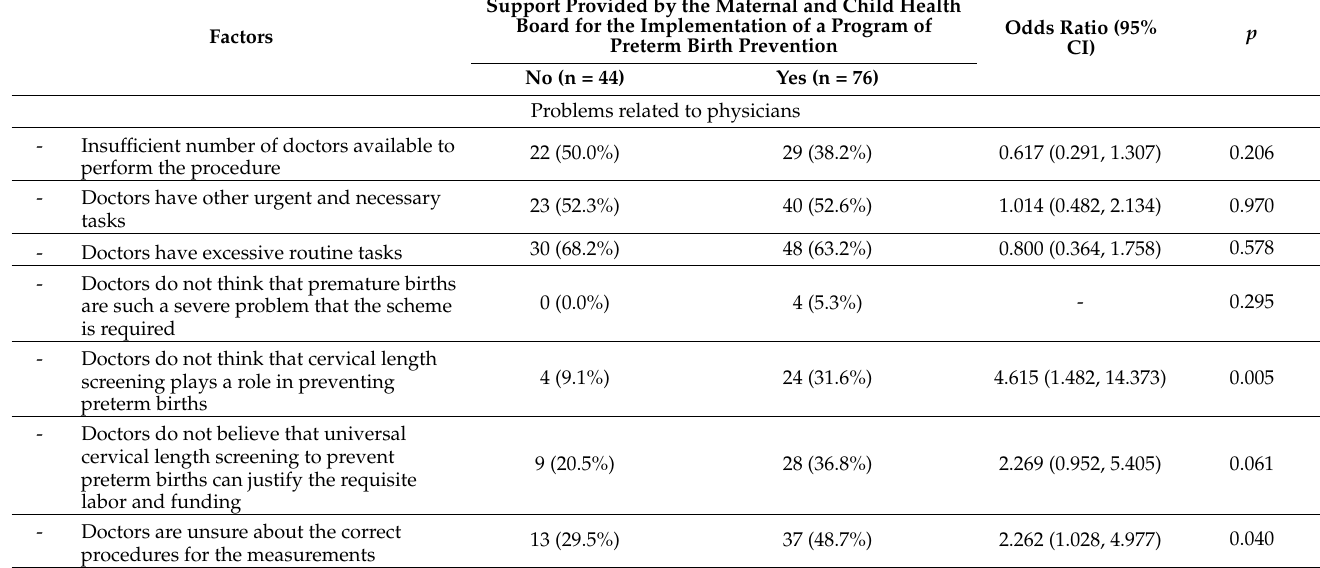
Table 5. Factors associated with support provided by the Maternal and Child Health Board for implementation of preterm birth prevention